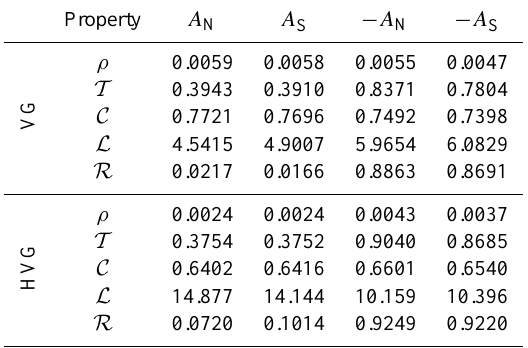
Table B2. VG properties for gamma-distributed white noise with S = 1 . 9 and T = 1667 as for the sunspot time